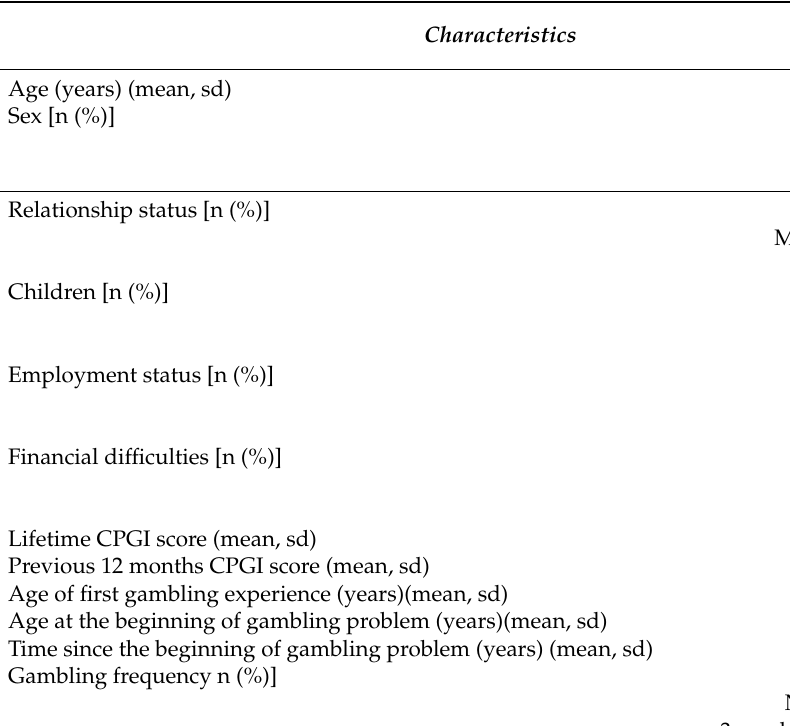
Table 1. Characteristics of cognitive debriefing interview patient